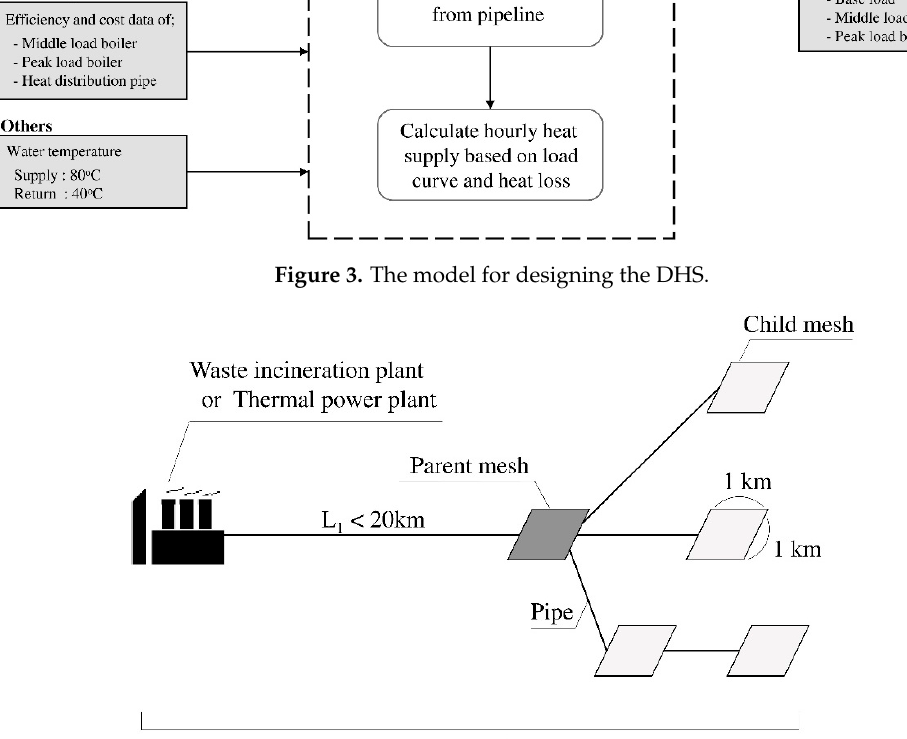
Figure 4. Allocation of the DHS components.